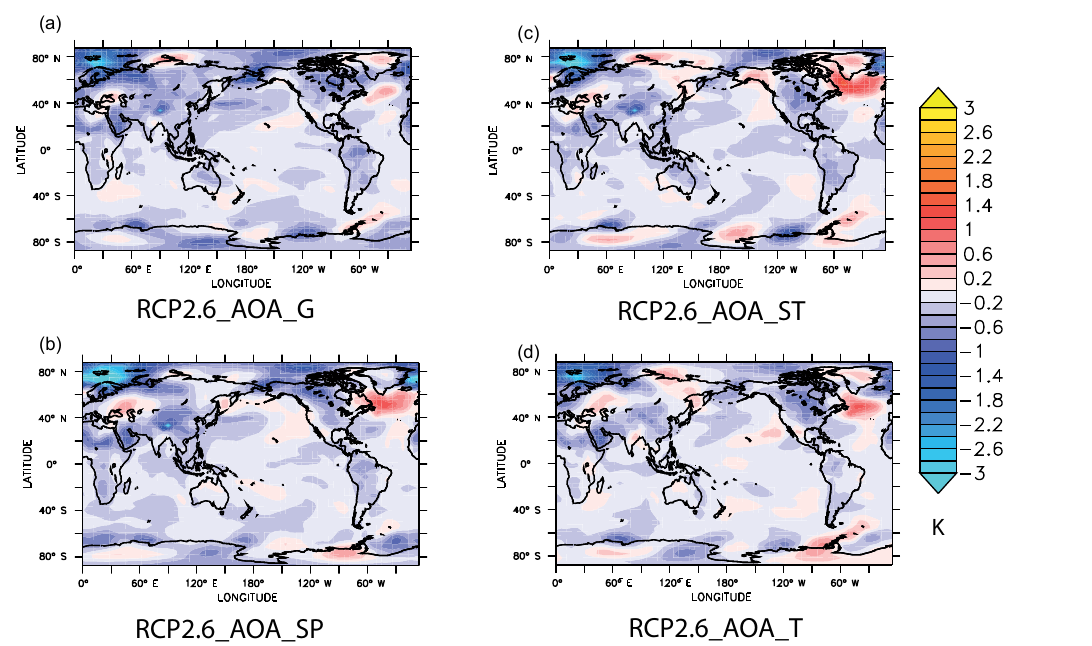
Figure 8. The spatial map of the changes in surface air temperature 2090 (mean; 2081–2100) associated with global and regional AOA under RCP2.6, relative to the RCP2.6 with no AOA. Units are K.